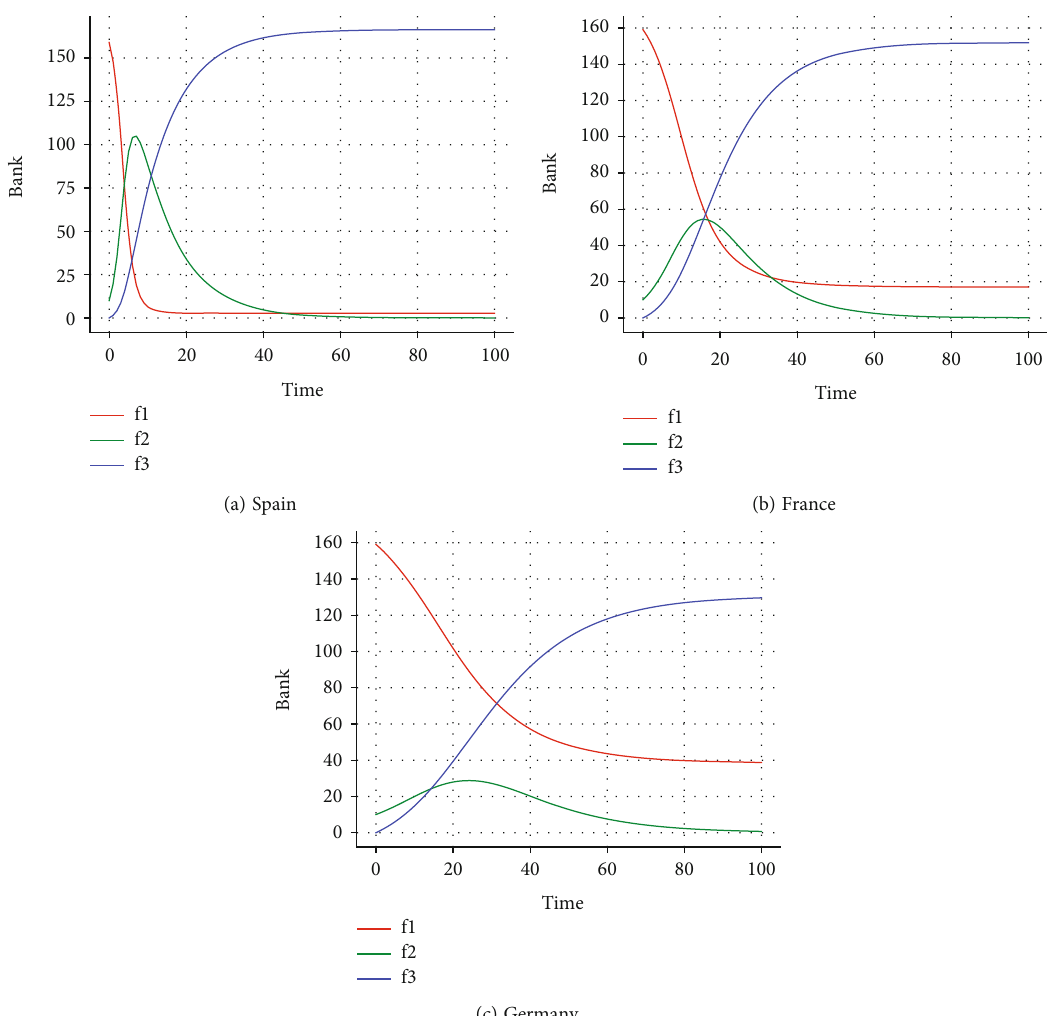
Figure 3: Liquidity risk in Spain, France, and Germany behavior over time with α